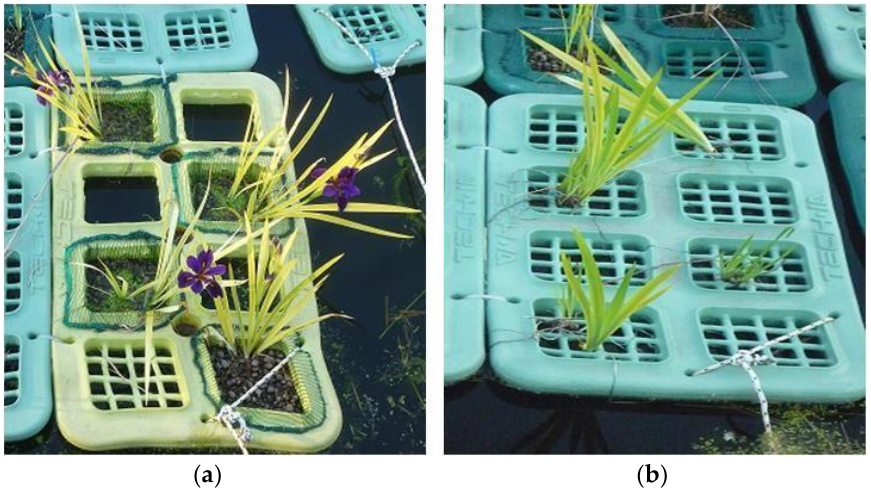
Figure 8. Nutritional deficiency symptoms were observed in all species: the example of Iris cultivated with ( a ) and without ( b ) substrate is reported.